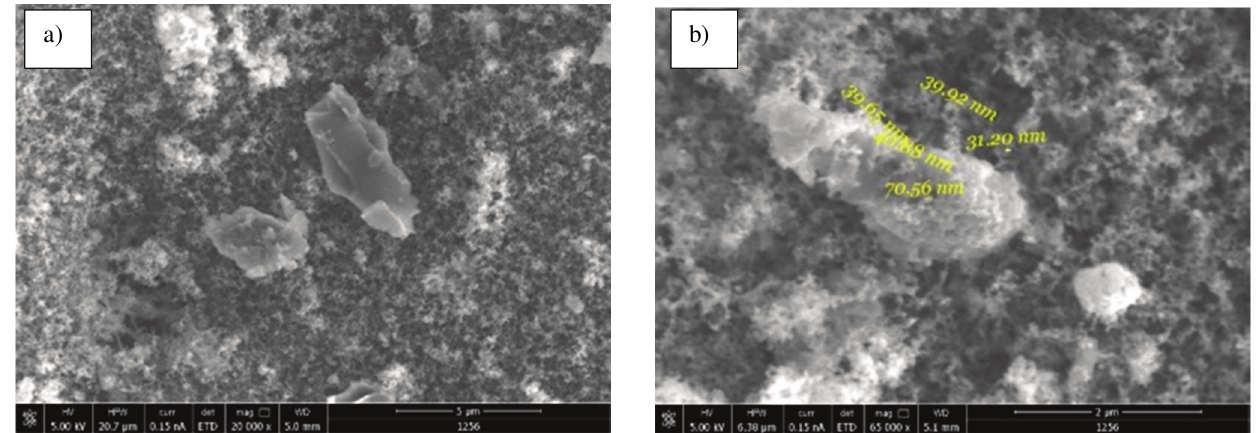
Fig. 4. SEM images of engine generated particles at different magnifications (a: 20 000 x; b: 65 000